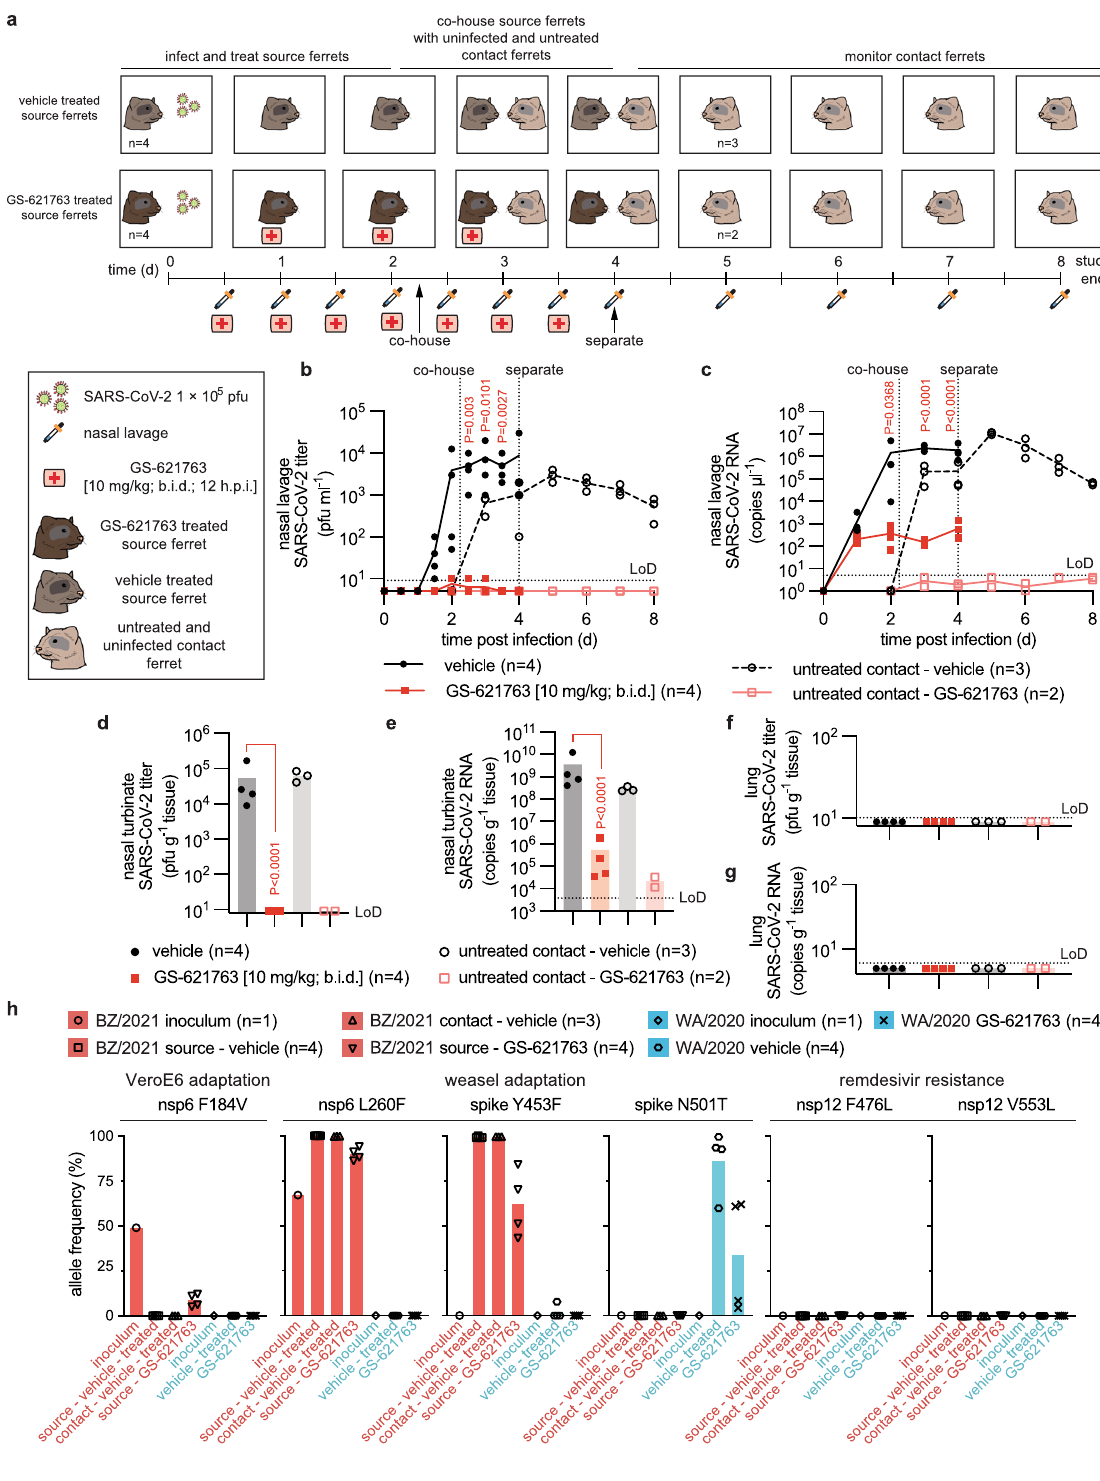
frequency, when viruses were extracted from treated animals at the time of termination (Fig. 4h, Supplementary Datasets 1, 2).